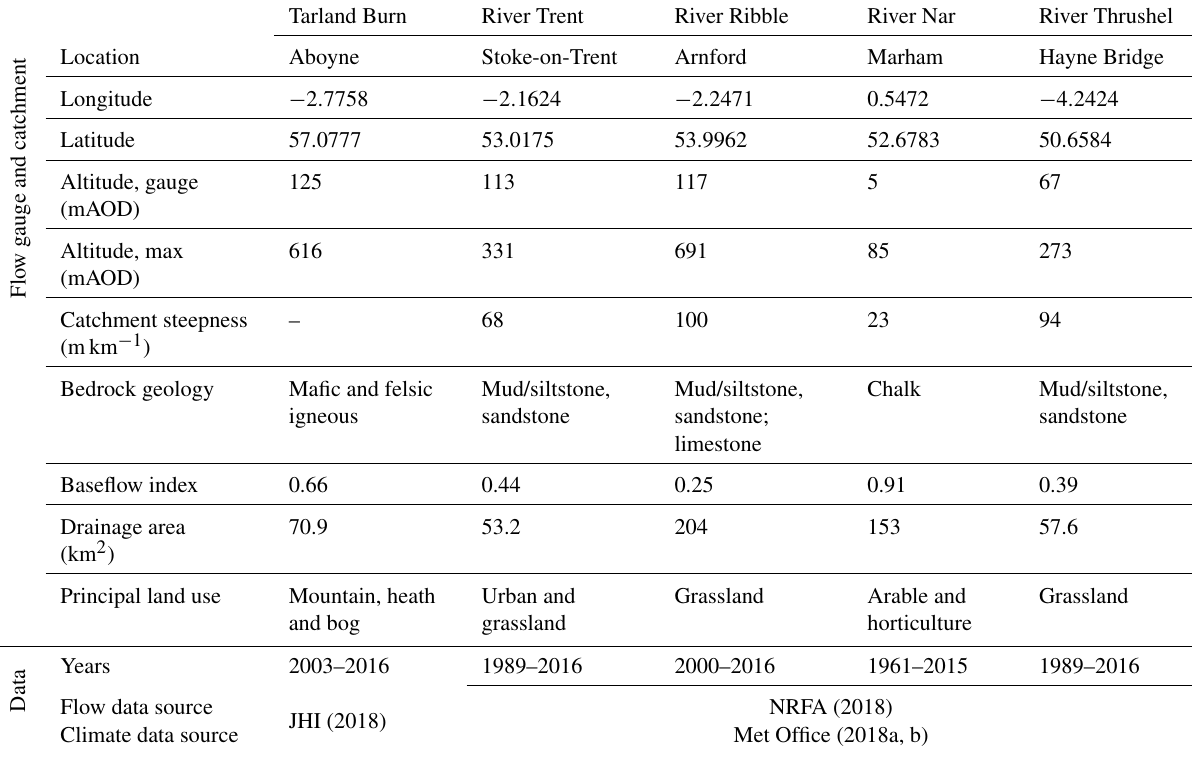
Table 1. Summary of case study catchment characteristics. Catchment steepness is unavailable for the Tarland Burn. Tarland Burn